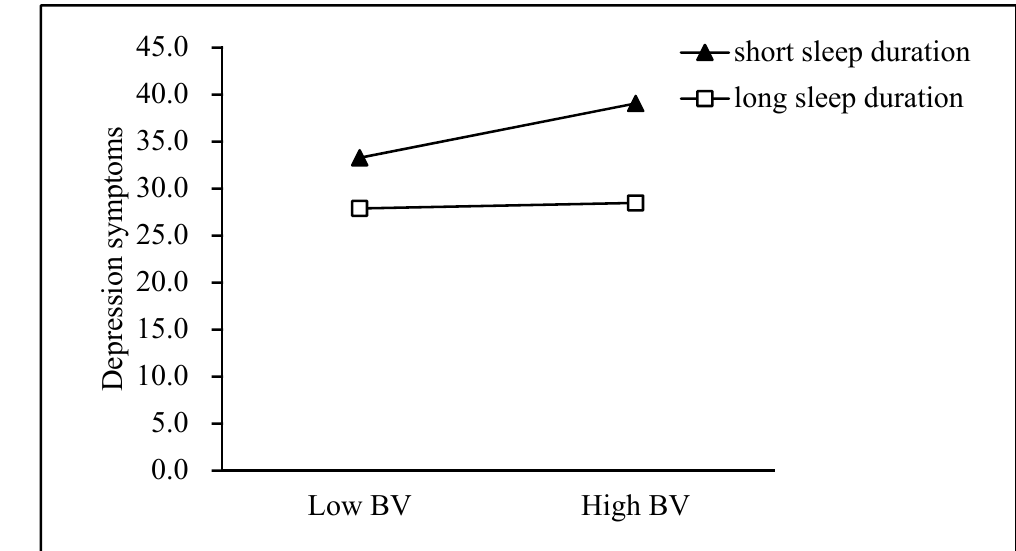
Figure 2. Sleep duration moderates the effect of bullying victimization on depressive symptoms. BV = Bullying victimization Bullying victimization predicted social anxiety for youth with longer sleep duration according to the test of simple slopes (see Figure 3) ( β short = 0.374, t = 5.367, p < 0.001, β long = 0.613, t = 5.070, p < 0.001).